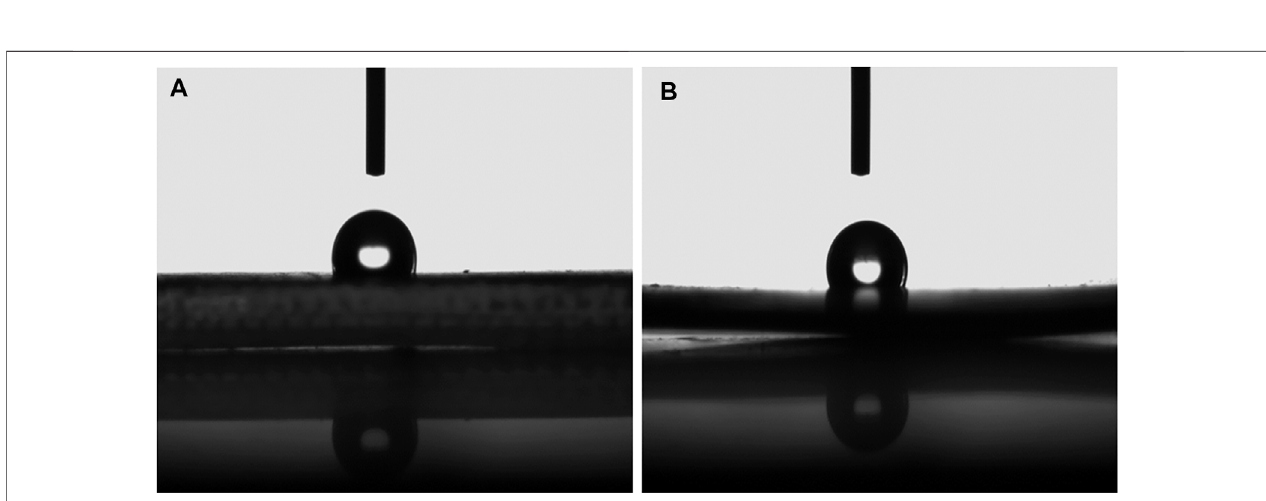
FIGURE 11 | Contact angle measurement of (A) native and (B) epoxy-modi fi ed CNCs (MCNCs).